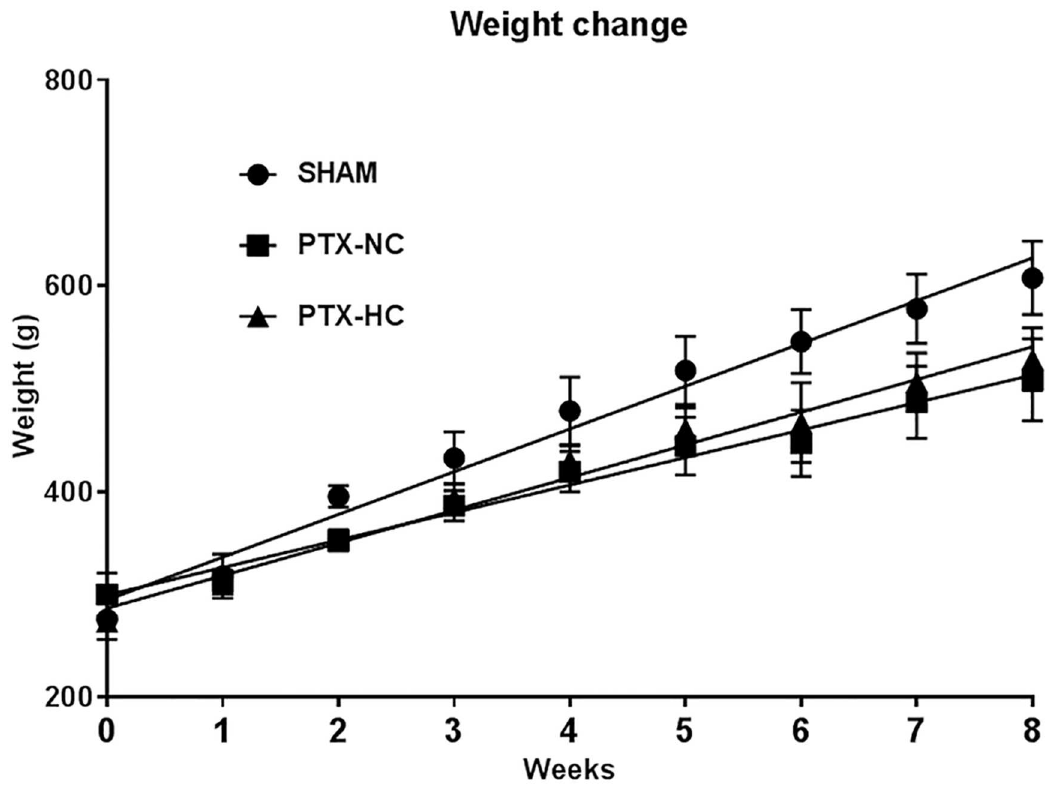
Fig 3. Weight changes of sham-operated and parathyroidectomized rats. All groups showed significant weight gain along the time course. (ANOVA, p = 0.000) The weight changes among the three groups were also significantlydifferent. (ANOVA, p < 0.001) Sham-operated rats showed the greatest weight gain. Among the parathyroidectomized groups, weight gain was greatest in the parathyroidectomized animals fed a diet containing2%